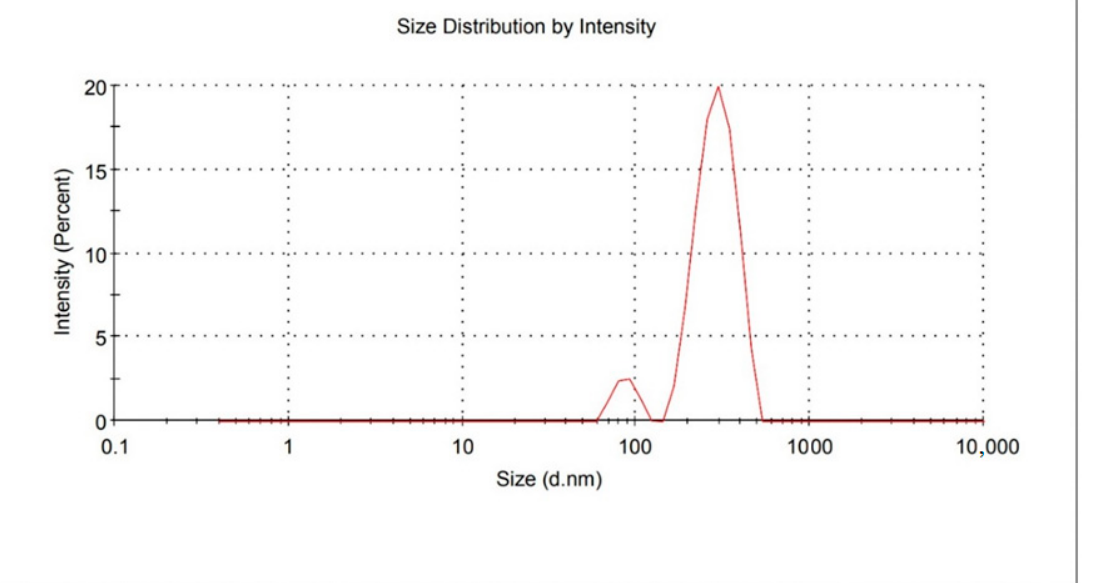
Figure 2. Zeta potential of the optimized FS3. 2.2. Entrapment Efficiency and Drug Loading Calculations The %EE and %DL values of the developed SLNs (FS1-FS5) was found in the range of 90.0 ± 2.65 ‒ 98.6 ± 5.15% and 10.2 ± 0.2 ‒ 18.8 ± 2.8%, respectively. Based on the results (Table 1), an increase in lipid content in SLNs formulation, an increase in the particle size, EE and DL were noted. The higher percentage of the EE could be due to the greater space of the drug in the lipid matrix and the higher intactness of the SLNs prepared from solid lipid stearic acid (SA) [18]. It was observed in the previous study of Baricitinib-loaded lipid-polymer hybrid nanoparticles that increasing the lipid content, increases the particle size and improve the entrapment efficiency by preventing the drug diffusion from the lipidic core [21].